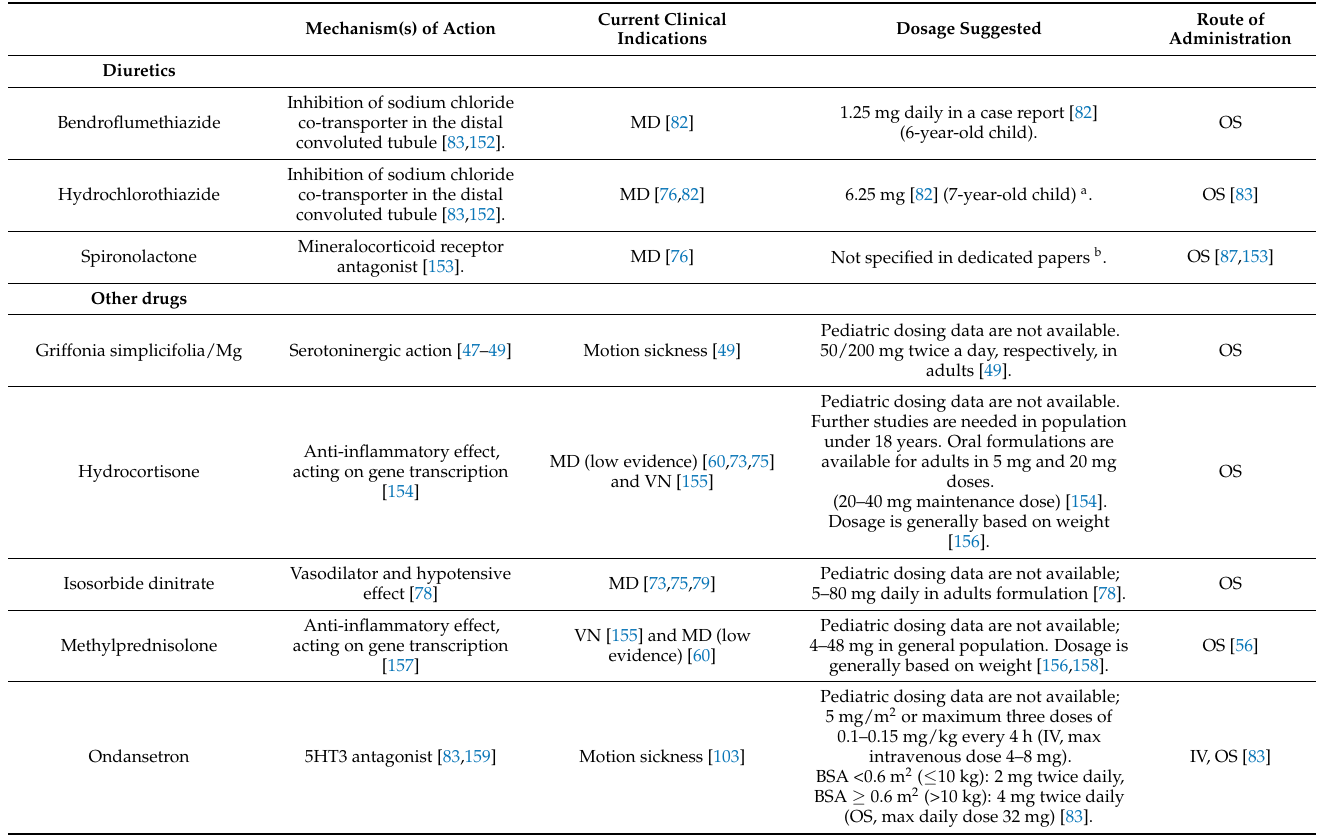
Table 7. Rationale, current clinical indications, and dosages of peripheral vestibular vertigo drugs in children (potentially useful drugs, with no trials in